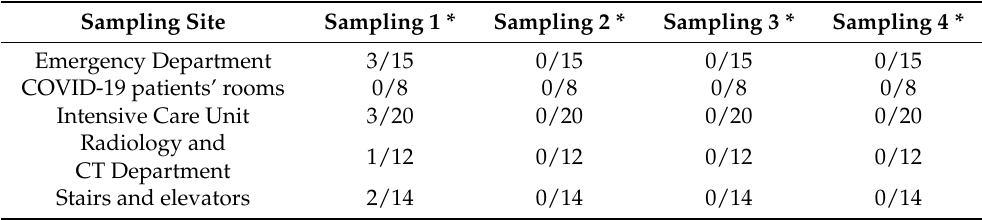
Table 2. Samples tested positive for fungi in Hospital A by sampling site and sampling